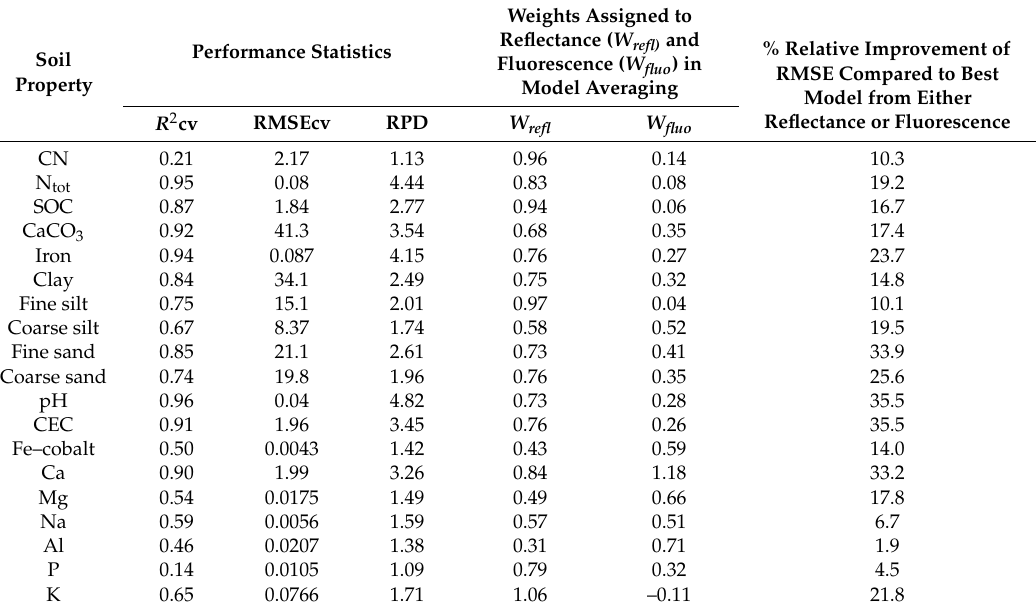
Table 8. Cross-validation performance statistics of averaged model for all horizons.